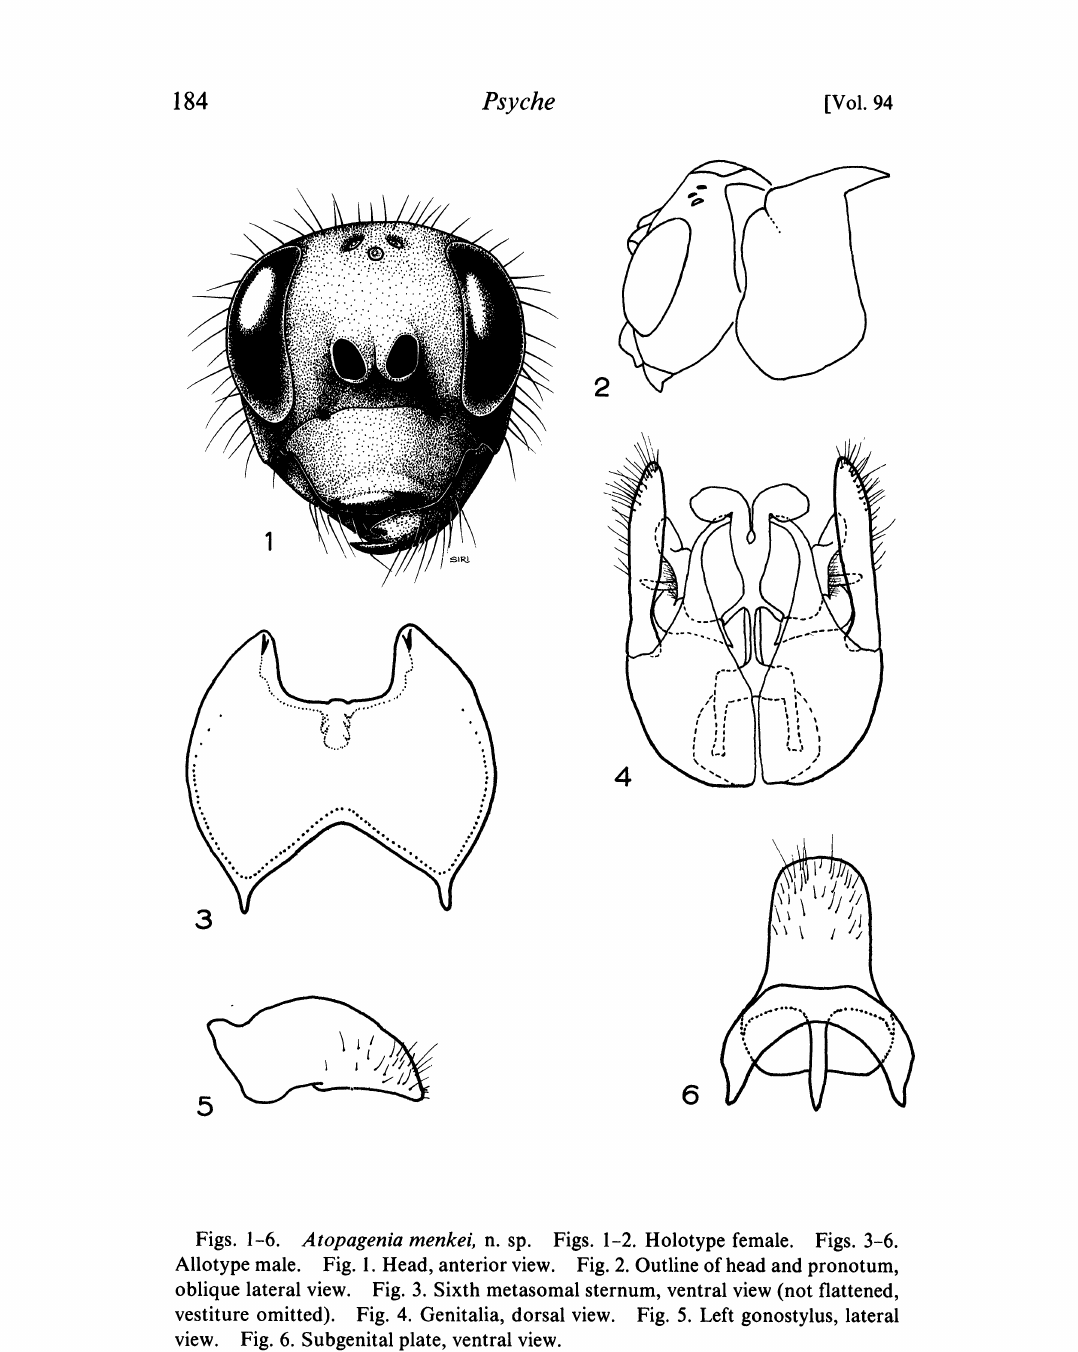
Figs. 1-6. Atopagenia menkeL n. sp. Figs. 1-2. Holotype female. Figs. 3-6. Allotype male. Fig. I. Head, anterior view. Fig. 2. Outline of head and pronotum, oblique lateral view. Fig. 3. Sixth metasomal sternum, ventral view (not flattened, vestiture omitted). Fig. 4. Genitalia, dorsal view. Fig. 5. Left gonostylus, lateral view. Fig. 6. Subgenital plate, ventral